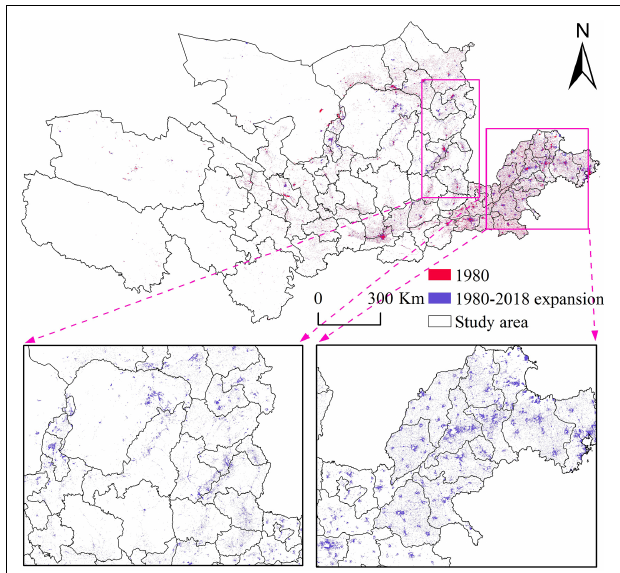
FIGURE 4 | Spatial changes of built-up land, 1980–2018.